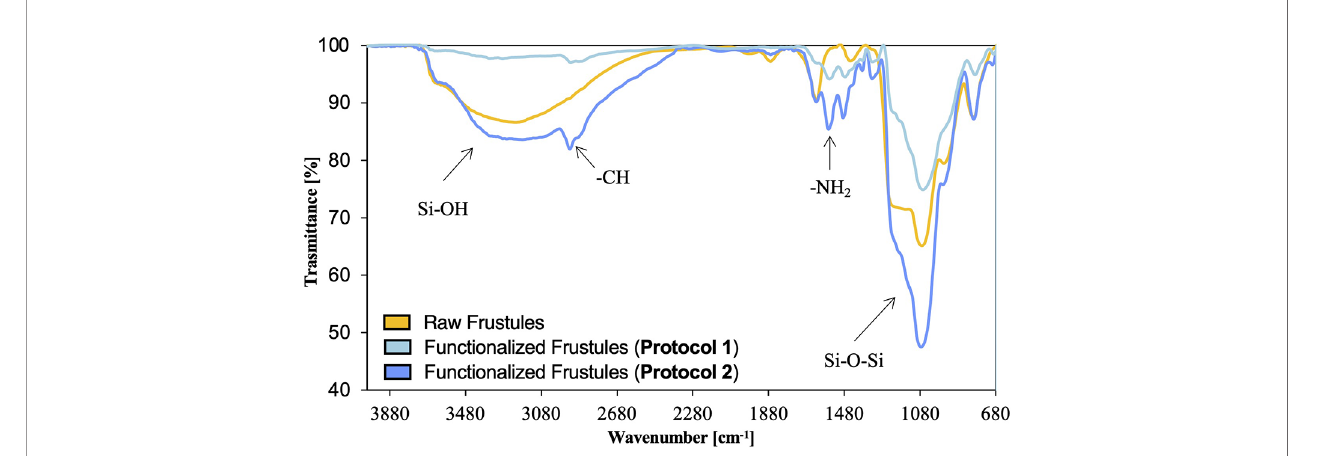
FIGURE 6 | FTIR spectra of raw and functionalized frustules using Protocol 1 and Protocol